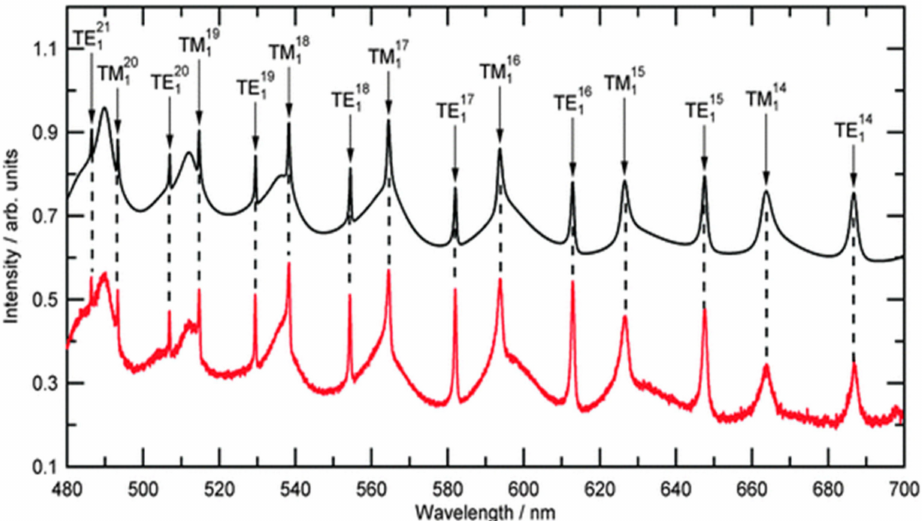
Figure 3. A typical recorded experimental Mie spectrum for an optically trapped polystyrene bead is shown in red. The calculated Mie spectra for a polystyrene bead of size 1.227 µ m, and a dispersion of refractive index, are shown in black and are offset by 0.5 arbitrary units (reprinted from [95] with permission under Creative Commons Attribution license, Copyright (2013) The Royal Society of